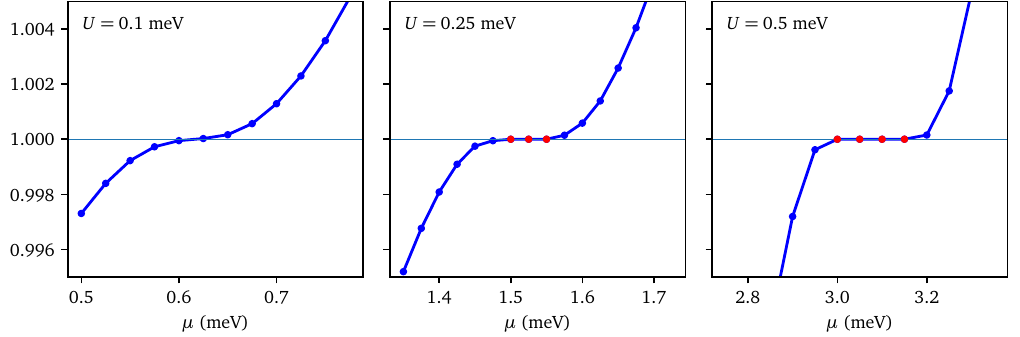
Figure 6: Electronic density vs chemical potential µ for different interaction strengths at half filling, similar to Fig. 3. The presence of a plateau (in red) is the signature of an insulating state, and the width of the plateau is the magnitude of the gap. The insulator-to-metal transition occurs between U = 0.1 meV and U = 0.25 meV.